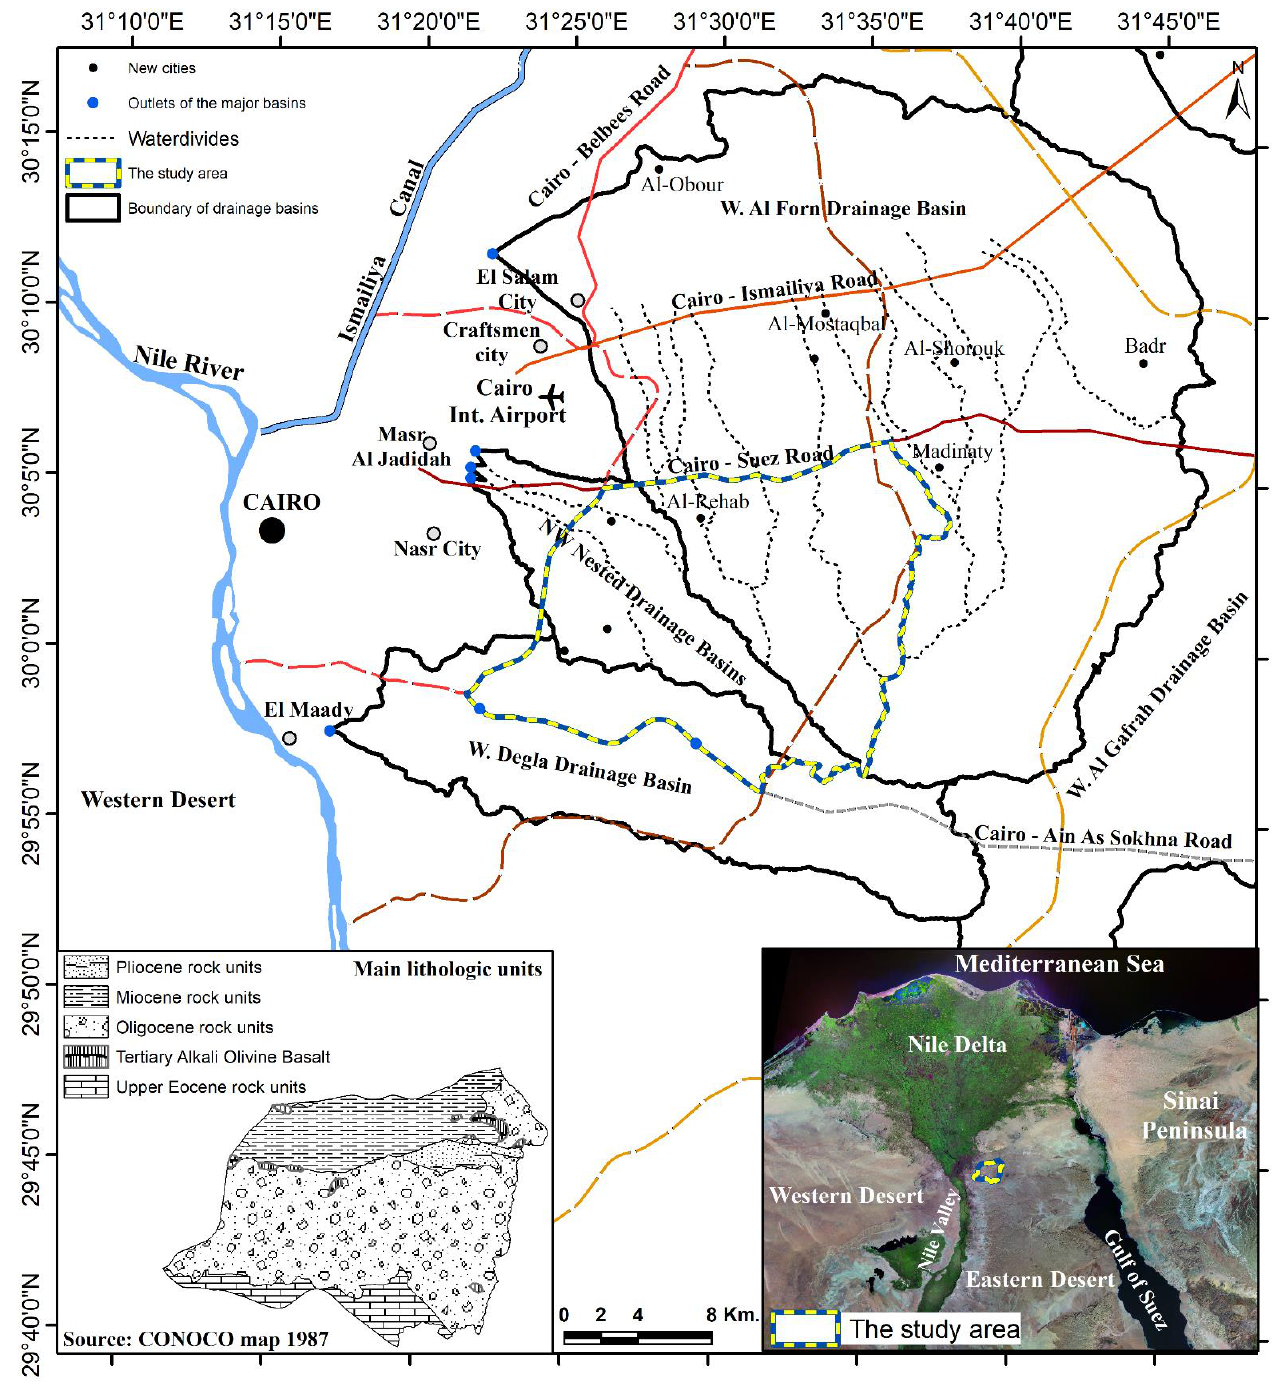
Figure 1. The location of the study area.